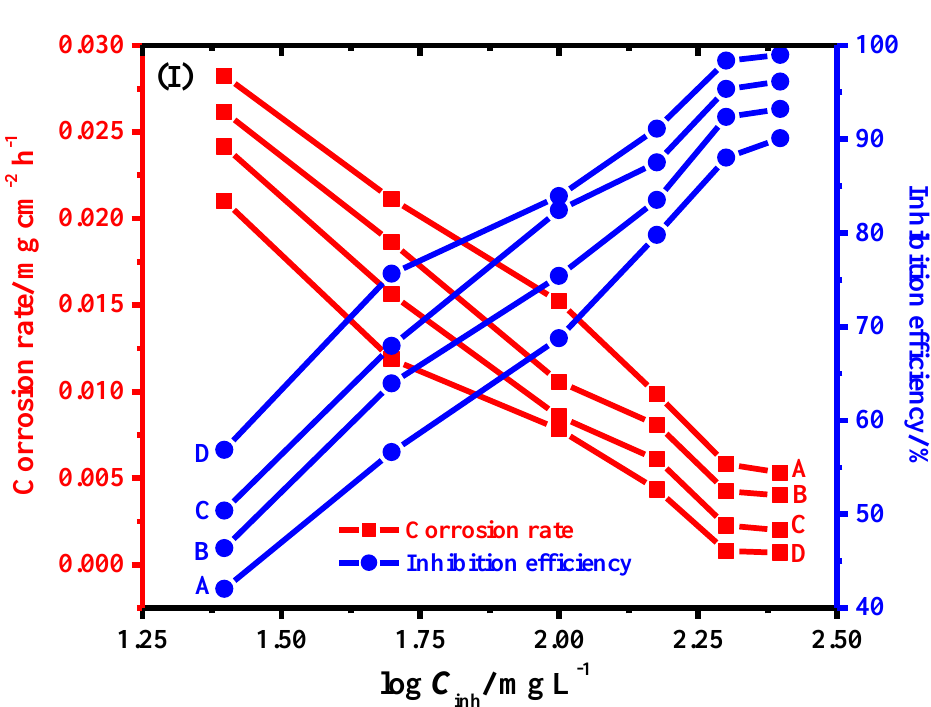
Figure 5. Change of corrosion rate and inhibition efficiency of C-steel in 1.0 M HCl solution with concentration of ( A ) PAC, ( B ) PAC/CuONPs/, ( C ) PAC/Fe 3 O 4 NPs and ( D ) PAC/NiONPs at 303 K.